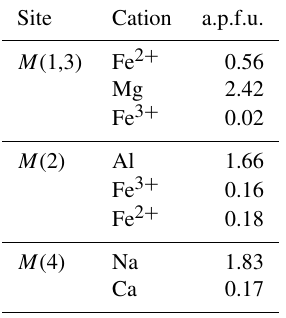
Table 3. Calculated site occupancies for